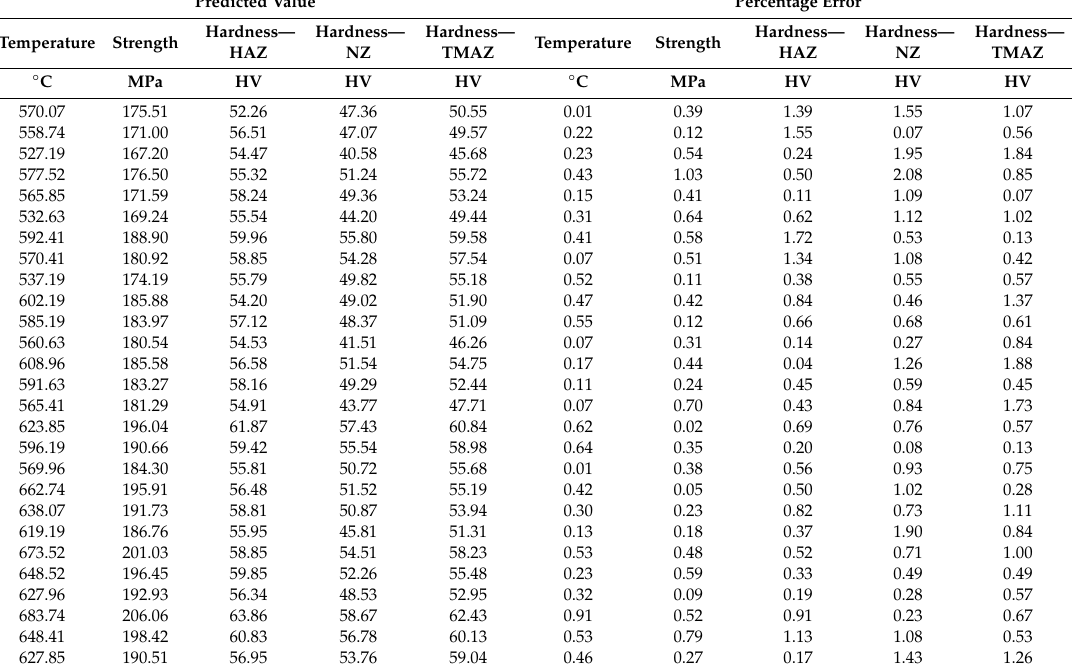
Table 7. Predicted responses and percentage